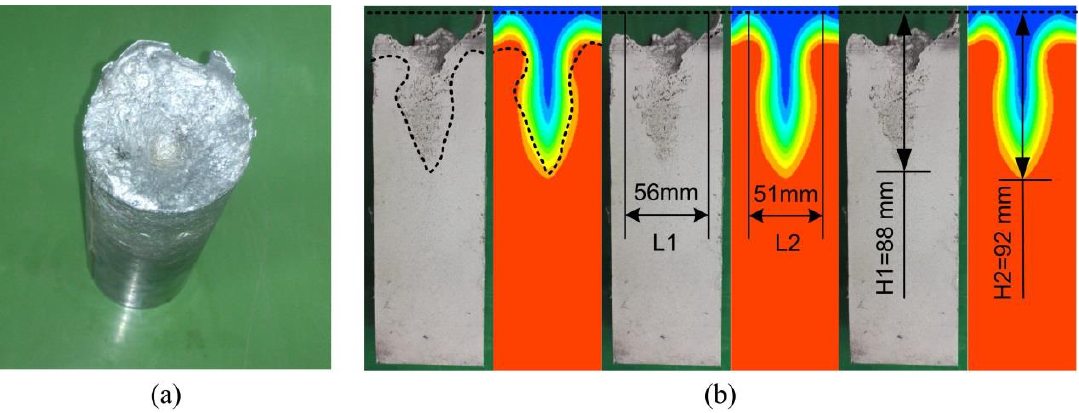
Figure 7. ( a ) Experimental overview and ( b ) the comparison of the vertical section between the experimental and simulation vortices.